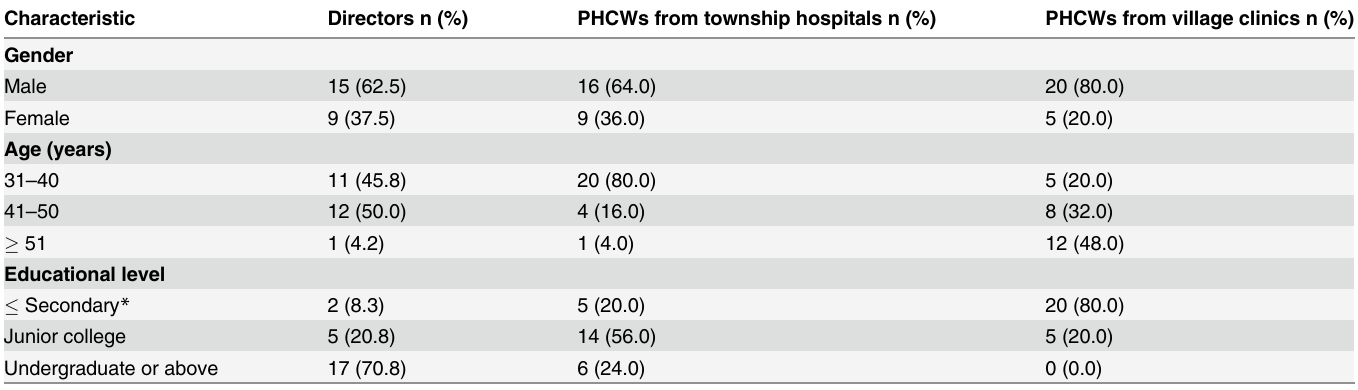
Table 1. Participant demographic